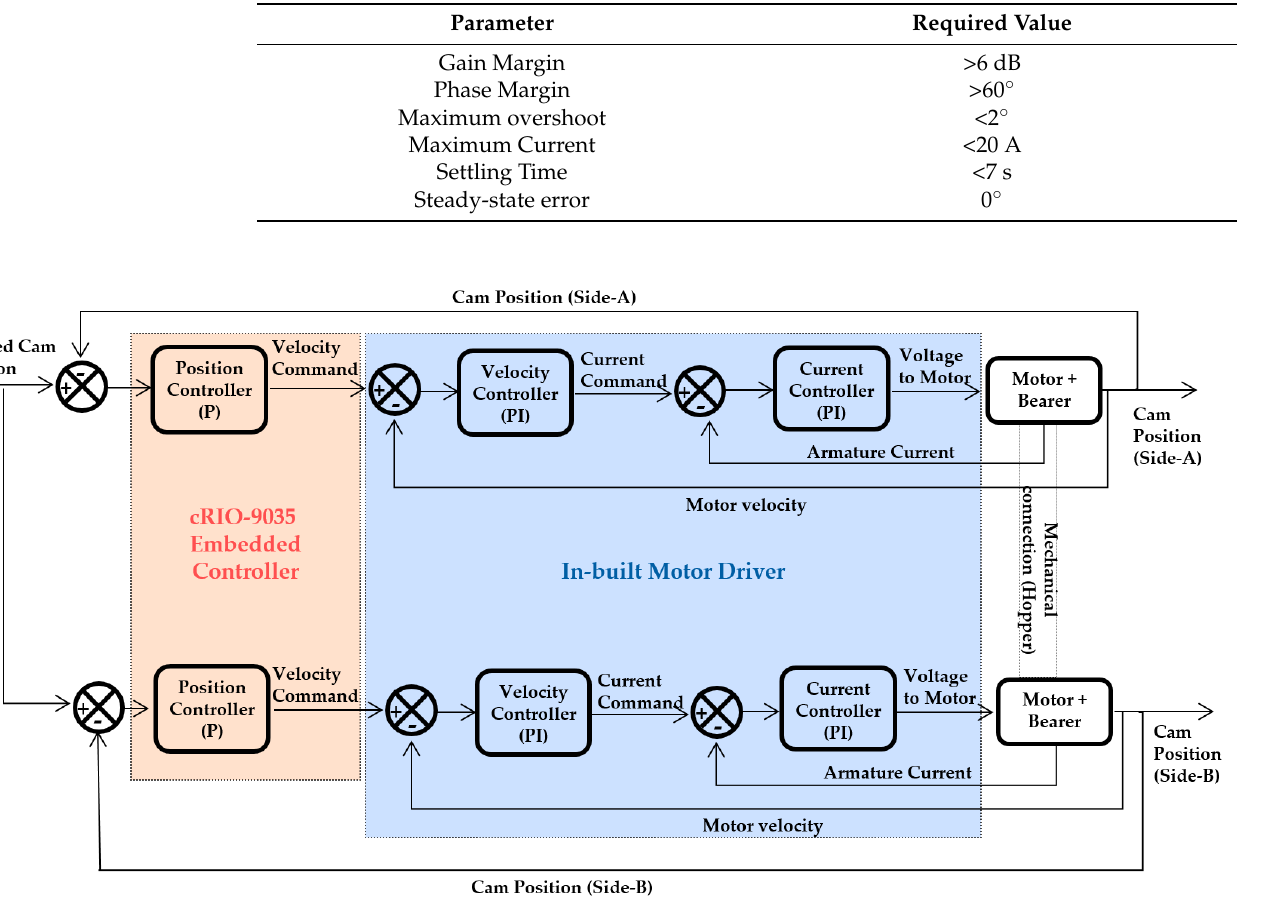
Figure 8. Designed single bearer level controller for the track switch.